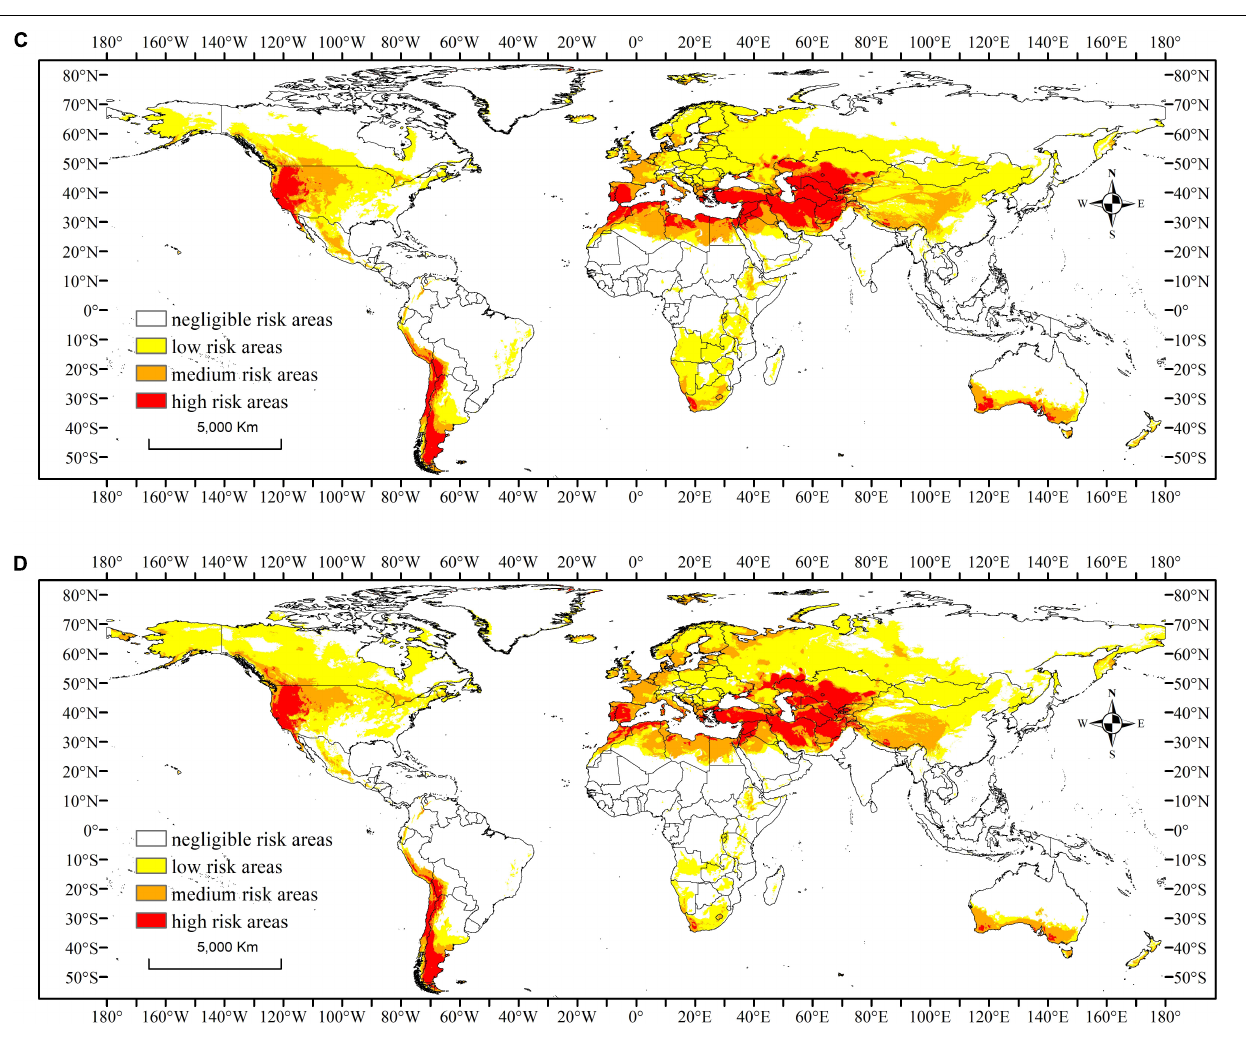
FIGURE 3 | Potential geographical distribution of Carpomya pardalina in 2030 and 2070 under future climate conditions as predicted by MaxEnt modeling. Mean predicted results are from three global climate models [BCC-CSM2-MR (BCC), IPSL-CM6A-LR (IP), MIROC-ES2L (MI)] which were modeled under (A) 2030-SSP126; (B) 2030-SSP585; (C) 2070-SSP126; and (D) 2070-SSP585. White indicates negligible risk areas, yellow indicates low risk areas, orange indicates medium risk areas, and red indicates high risk areas. SSP5-8.5 refers to a Shared Socio-economic Pathway (SSP) scenario from the IPCC sixth assessment